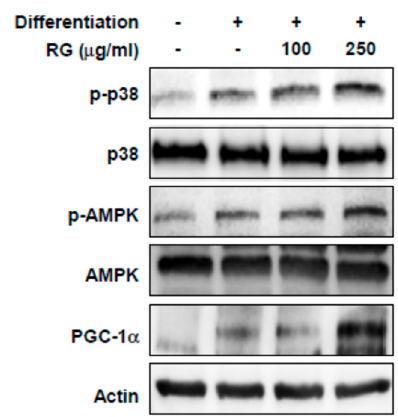
Figure 4. Effects of RG on phosphorylation levels of p38, AMP-activated protein kinase (AMPK) and PGC-1 α in C2C12 myotubes. Cells were induced to differentiate for 2 days, and then cells were treated with 100 and 250 μ g/mL of RG for 48 h. Cell lysates were immunoblotted with antibodies against phosphorylated-p38 MAPK (p-p38), phosphorylated AMPK (p-AMPK), total p38, AMPK, PGC-1 α and actin as a loading control.